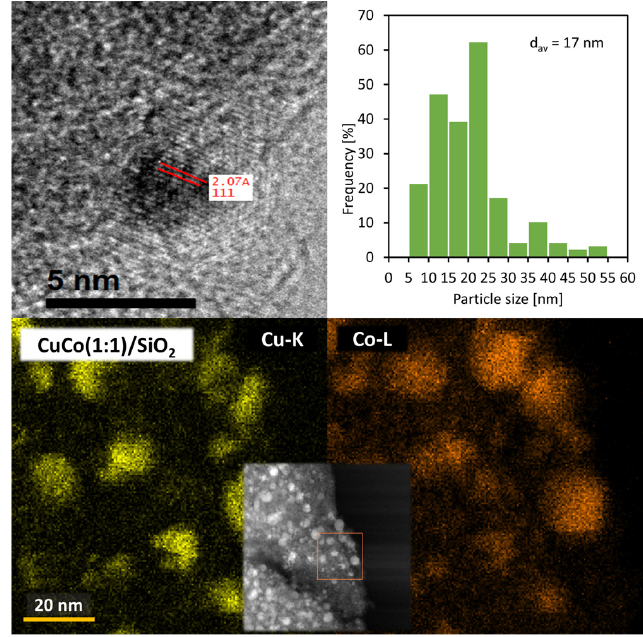
Figure 5. Interplanar distance, TEM mapping and particle size distribution of CuCo(1:1)/SiO 2 .